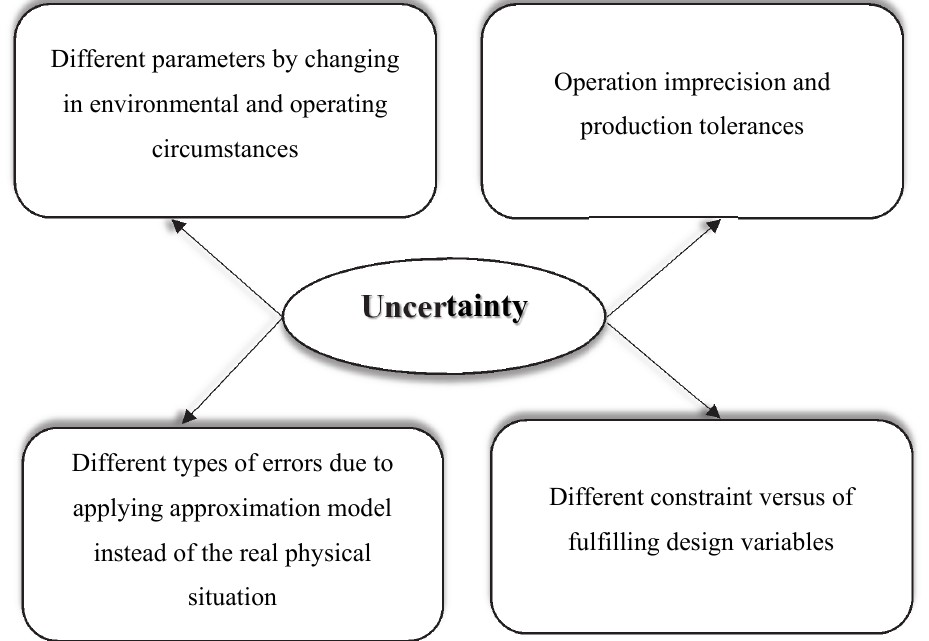
Fig. 3. Different types of